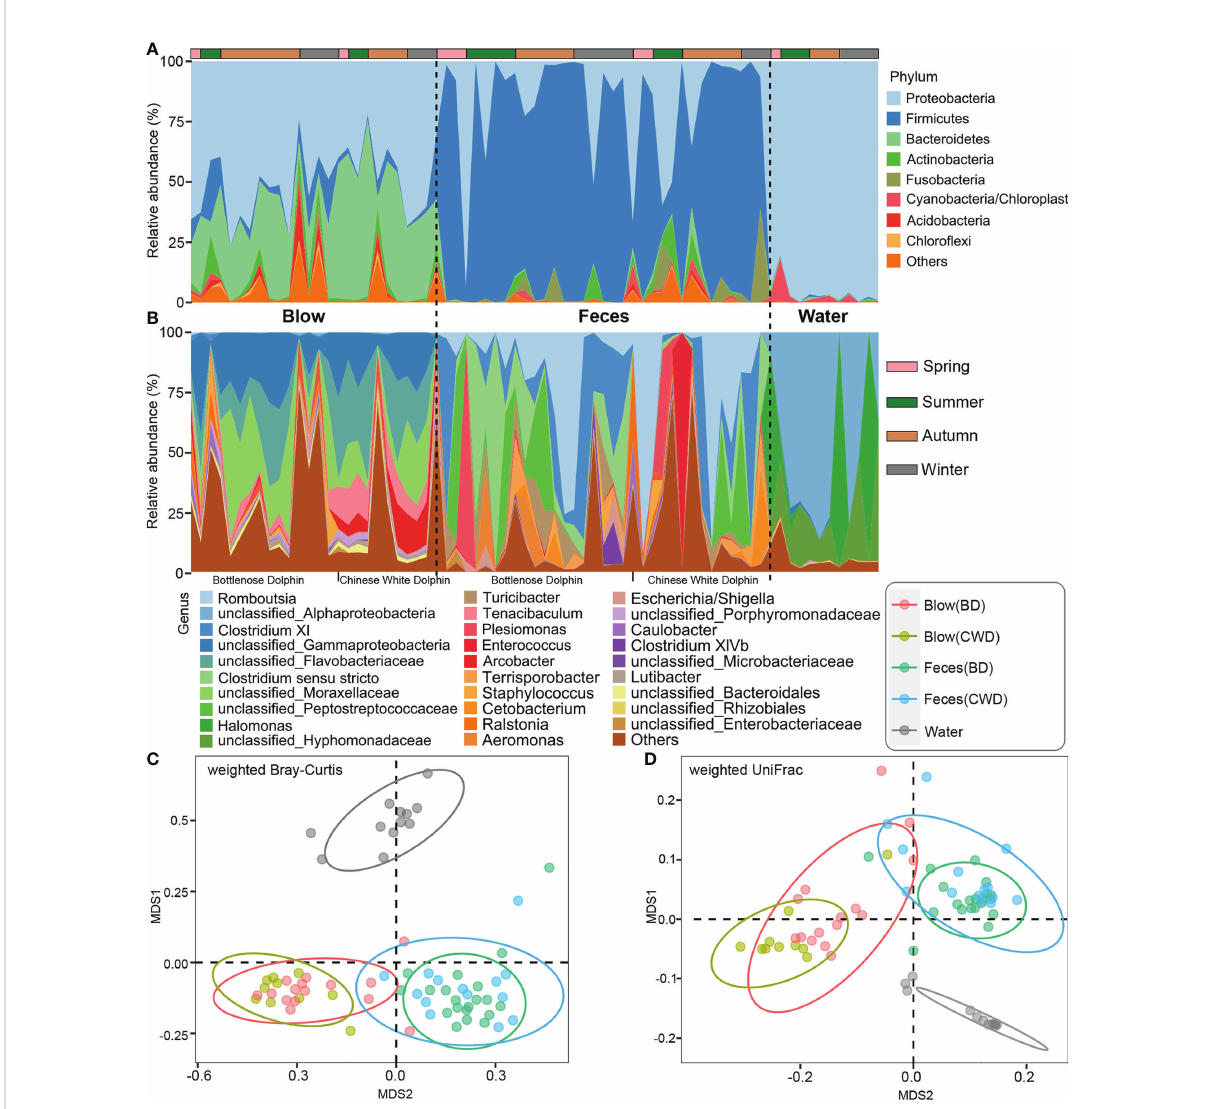
FIGURE 1 Composition and comparison of microbiota from the dolphin blow, feces, and pool water. (A) , the relative abundance of each phylum. A total of 28 phyla were detected. Only the top 8 most abundant phyla are shown here; the remaining 20 phyla as well as unclassi fi able sequences were grouped as ‘ Others ’ . (B) , the relative abundance of each genus. A total of 571 genera, including unclassi fi ed genera, were detected. Only the top 29 most abundant genera are shown here; the remaining genera including unclassi fi able sequences were grouped as ‘ Others ’ . The horizontal lines at the top indicate the collecting season of each specimen. (C) , the non-metric multidimensional scaling (NMDS) analysis of different sampling groups at the OTU level based on weighted Bray-Curtis distances. (D) , the NMDS analysis of different sampling groups at the OTU level based on weighted UniFrac distances. BD indicates the bottlenose dolphin, and CWD indicates the Chinese white